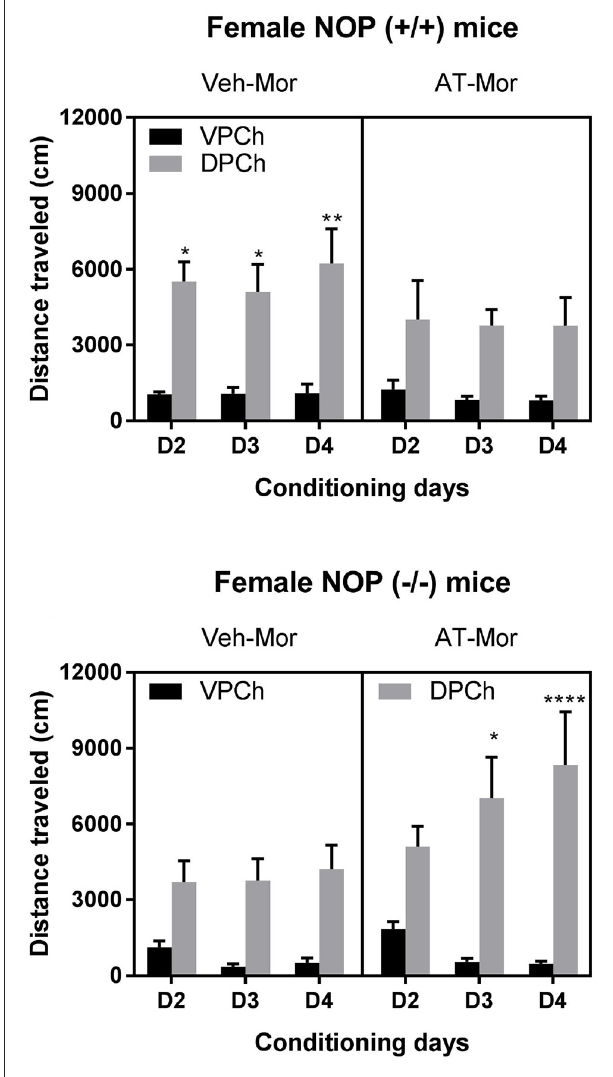
FIGURE 1 | Effects of AT-312 on morphine-induced CPP in mice lacking NOP and their wild-type littermates/controls. Mice ( n = 6 mice per treatment for each genotype) were tested for baseline place preference on day 1, conditioned with morphine (7.5 mg/kg, s.c.) in the presence and absence of AT-312 (3 mg/kg, i.p.) on days 2–4 and then tested for CPP on day 5. Vehicle or AT-312 was given 5min before morphine on each conditioning day to wild-type (Upper) and knockout (Lower) mice. * P < 0.05; ** P < 0.01; **** P < 0.0001, a significant increase in the amount of time that mice spent in the drug-paired chamber (DPCh) compared to vehicle-paired chamber (VPCh) on this day.